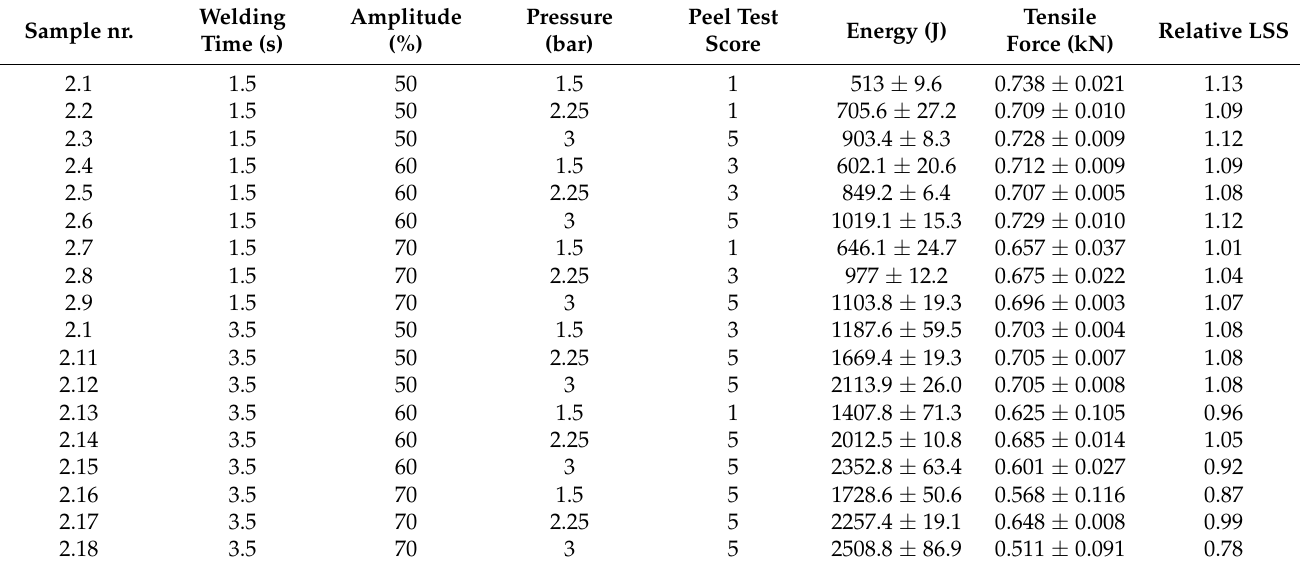
Table 3. Full factorial design of experiments and the welding energy and maximum force registered in the lap shear